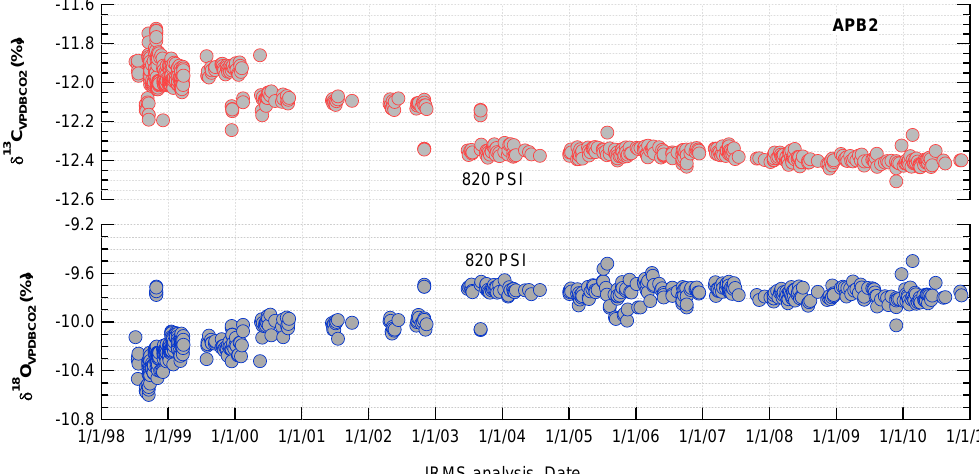
in a high pressure cylinder (APB2) over a 638 2